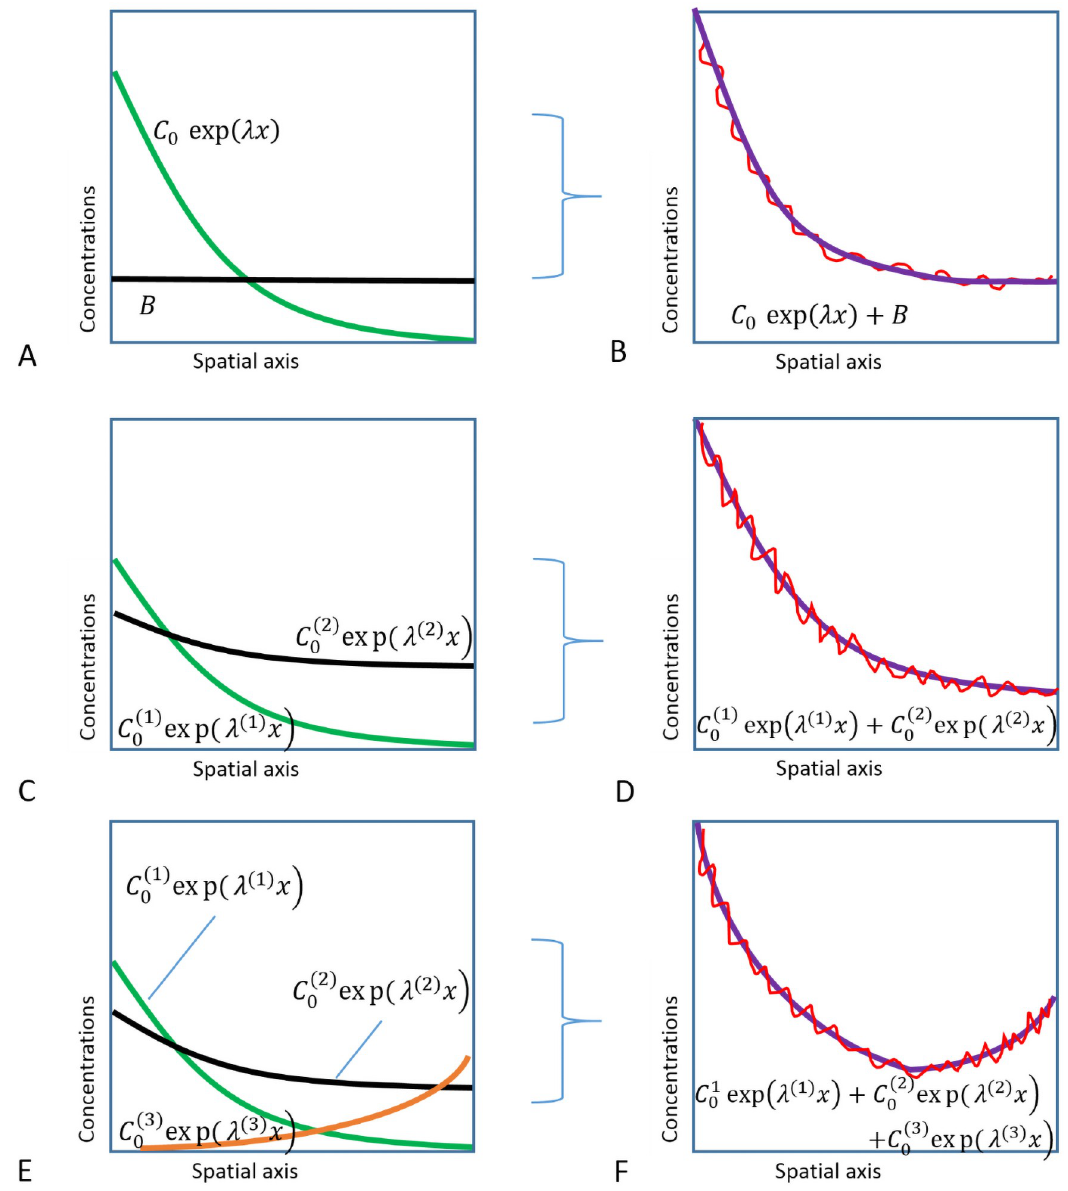
Fig 2. Approximating (purple, right) 1D anteroposterior experimental data profiles (red, right) by: (A-B) exponential (green, left) plus background (black, left); (C-D) two- (green, black); (E-F) or three-exponential (green, black, orange)